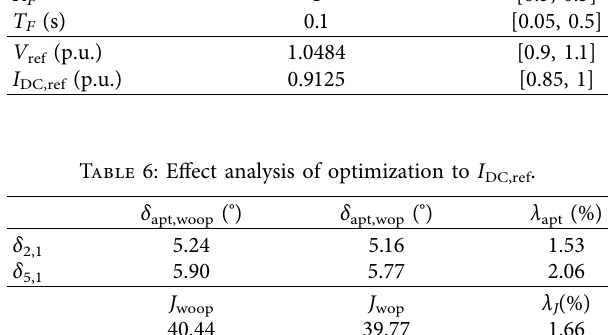
Table 5: Te initial values and ranges of the parameters.